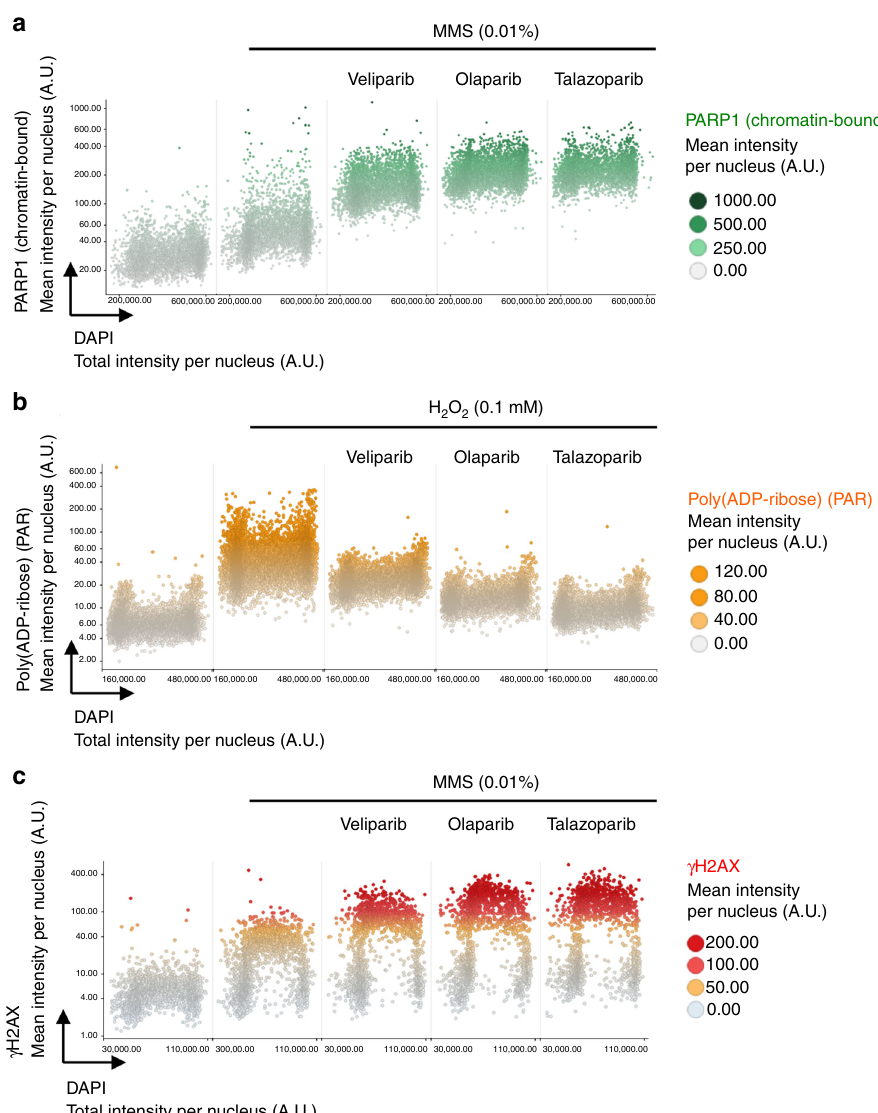
Fig. 4 Differential PARP trapping and PARP inhibition by a panel of PARPi. a U-2 OS cells were treated with different PARPi (10 μ M) for 4 h as indicated, pre-extracted on ice with 0.2% Triton X-100 for 2 min to remove soluble, non-chromatin-bound proteins, and stained for PARP1 and DNA content. Chromatin-bound PARP1 levels were quanti fi ed and are depicted as a function of cell cycle progression. b Cells were pre-incubated with different PARPi for 30 min as indicated, treated with H 2 O 2 for 10 min to induce PAR formation, and stained for PAR and DNA content. Cellular PAR levels were quanti fi ed and are depicted as a function of cell cycle progression. c Cells were treated with different PARPi (10 μ M) for 1 h as indicated, pre-extracted on ice in 0.2% Triton X-100 for 2 min and stained for γ H2AX and DNA content. γ H2AX levels were quanti fi ed and are depicted as a function of cell cycle progression. Color codes as de fi ned in the fi gure